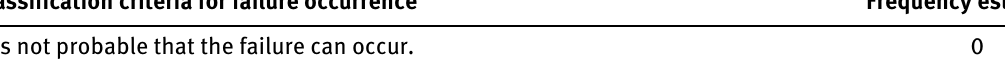
Table 1: Failure occurrence Classification criteria for failure occurrence